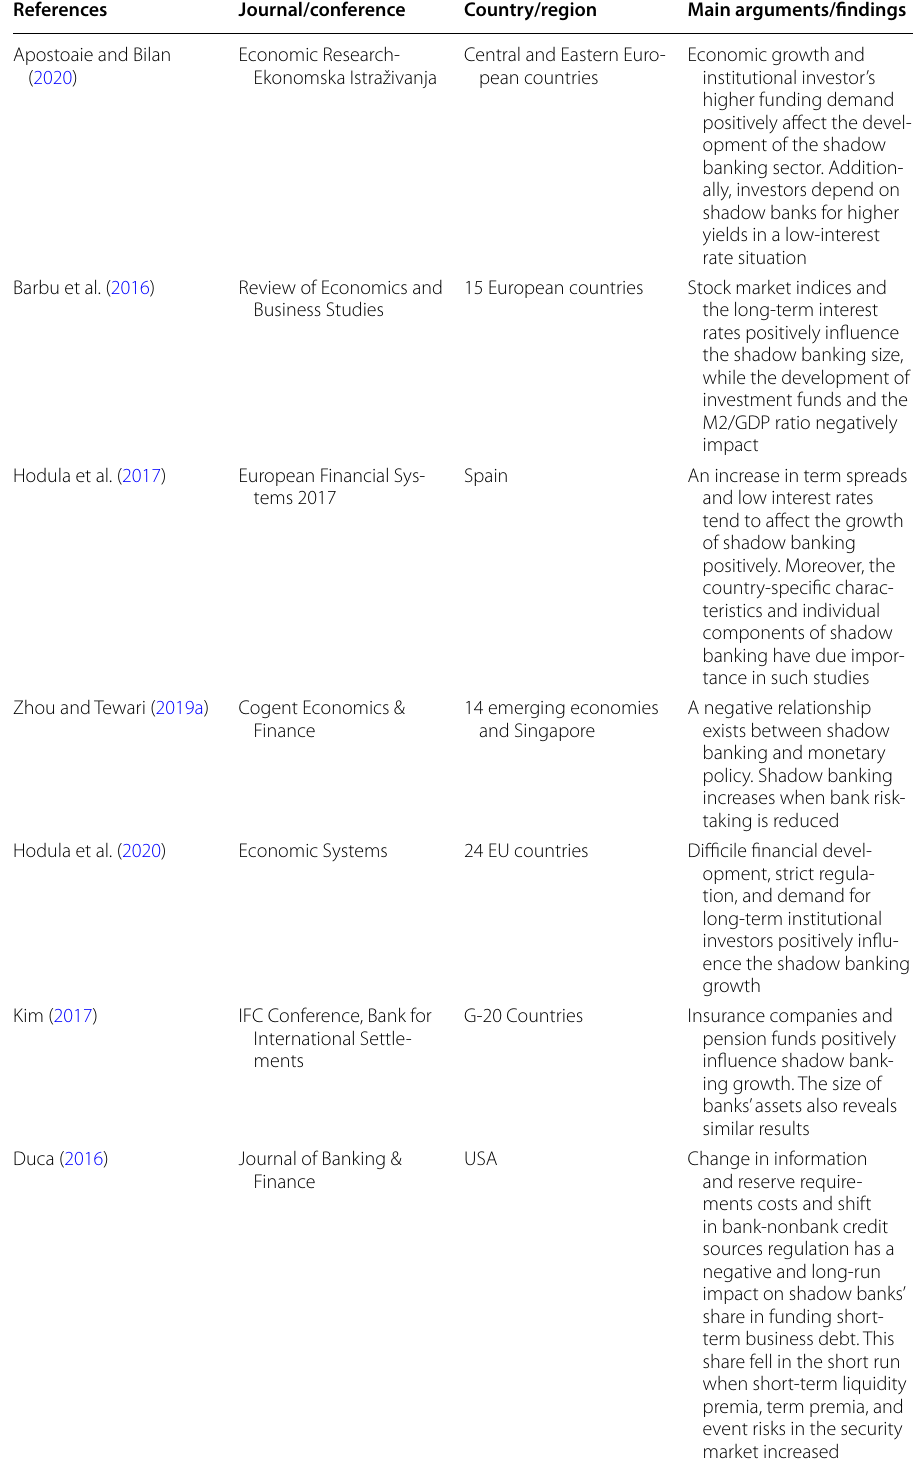
Table 4 Key literature on determinants of